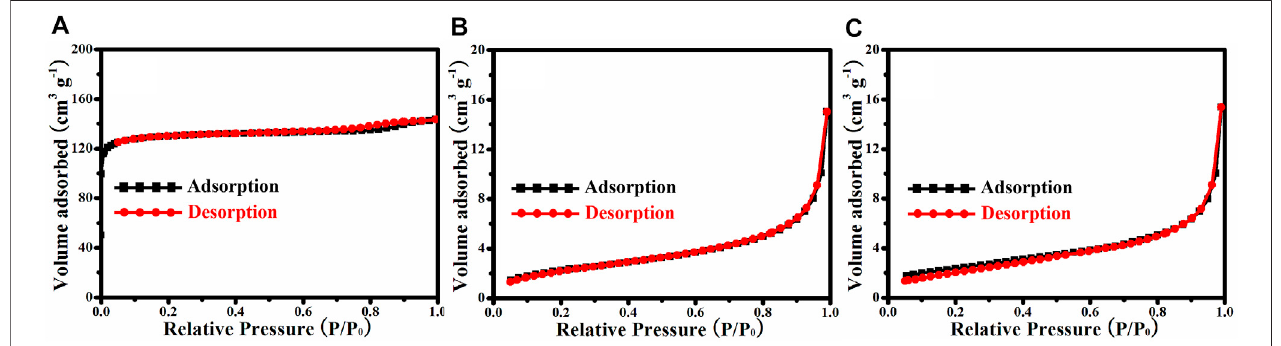
FIGURE 4 | N 2 adsorption – desorption isotherms of (A) MIL-125(Zn), (B) ZnO, and (C) Ag/ZnO.